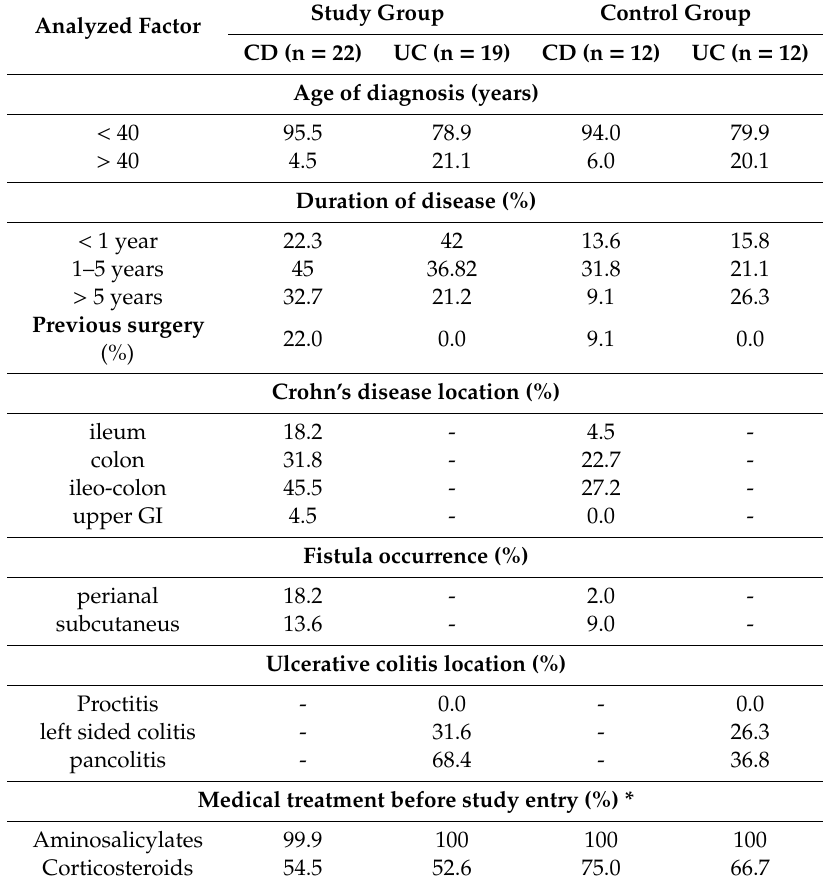
Table 1. Baseline characteristic of the study population (n =